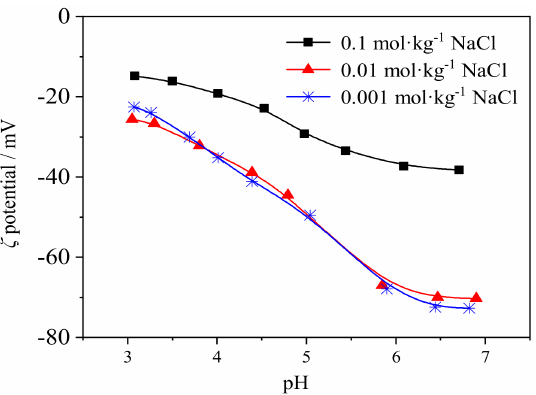
Figure 8. ζ potential of the REO colloid after NaCl concentration and pH value